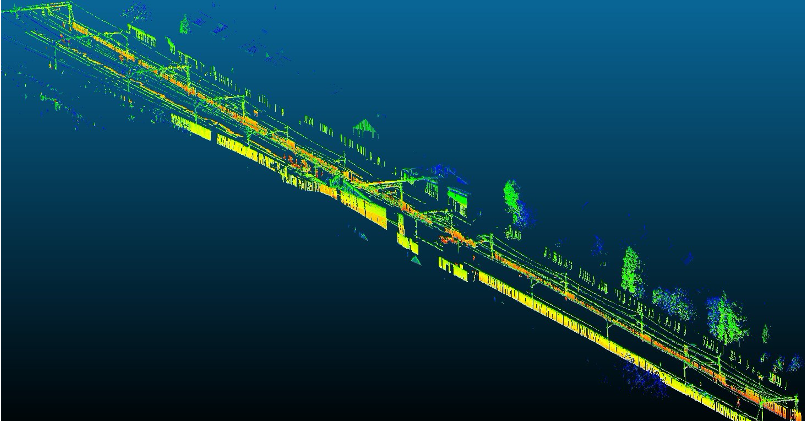
Figure 2. Point cloud provided by the Telice company of a track with standard gauge and flexible overhead contact